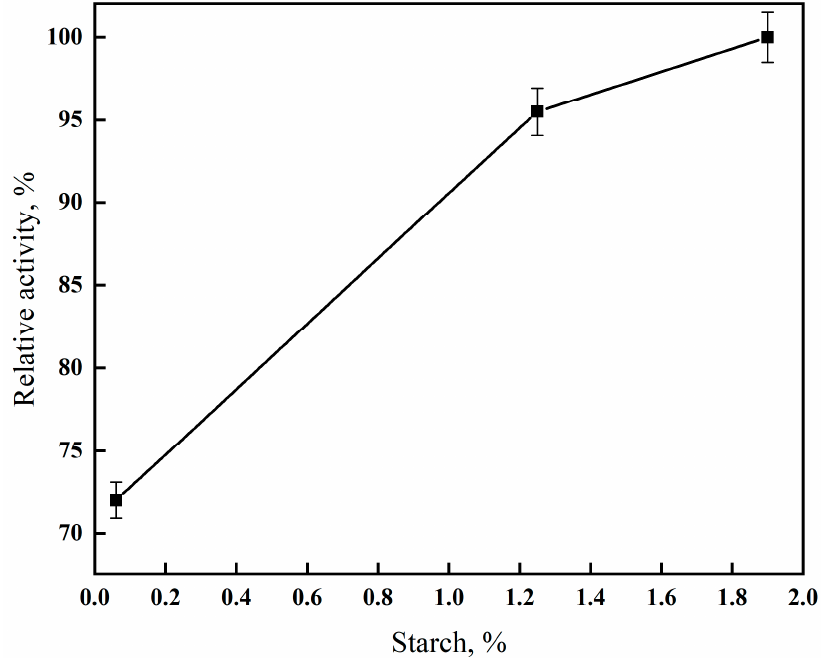
Figure 7. Reduced sugar produced after starch hydrolysis by α -amylase. Conditions: A 1 mL of reaction mixture contained different concentrations of starch (0.06, 1.25, and 1.9%), Tris–HNO 3 buffers, PH 7.0, incubates at 37 ◦ C, 1 mL of gelatin-silver reagent (1:3), heated for 10 min at 90 ◦ C, recorded absorbance at 434 nm. Each point represents the mean of three experiments ±